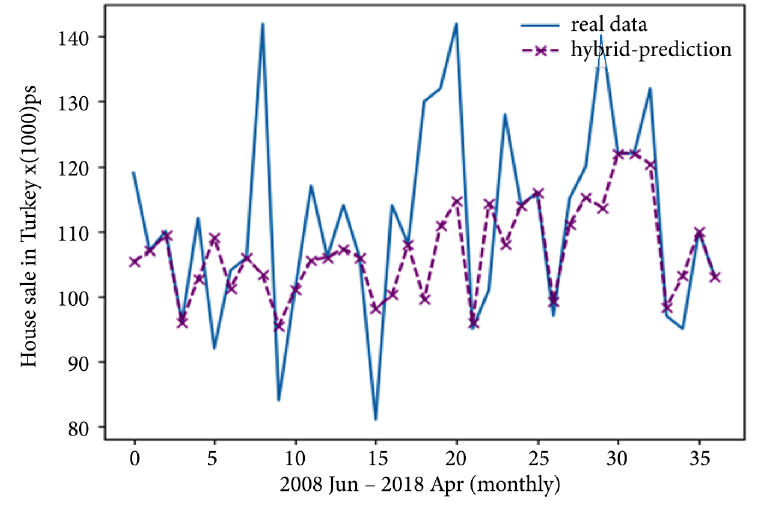
Figure 7. Hybrid model and ground